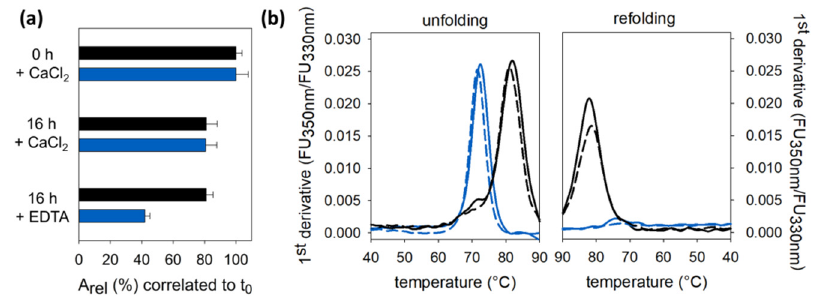
Figure 2. Evaluation of the contribution of the E70/80C disulfide bridge in aTn to the calcium dependence of enzymatic activity and the thermal stability ( a ) The bar chart shows the influence on the reduction of the relative activity A rel in the presence and absence (EDTA) of Ca 2+ after 16 h in comparison to the starting activity at 0 h (t 0 ). The activities were related to the respective starting point (A) of either aTn (shown in black) or wt-Tn (shown in blue). ( b ) The micro-thermophoresis method depicts the thermal denaturation of aTn (shown in black) and wt-Tn (shown in blue). A rel was determined at 30 °C in 100 mM HEPES (pH 7.8), 100 mM NaCl, and either 10 mM CaCl 2 or 0.2 mM EDTA using 16 nM of Tn variants and 200 µM Bz-Arg-AMC. Unfolding and folding was monitored using 20 µM trypsin, 10 mM CaCl 2 or 0.2 mM EDTA in 20 mM MES, 150 mM NaCl, pH 5.5. The temperature was increased from 40 to 90 °C at a ramp rate of 1 °C/min. Errors represent